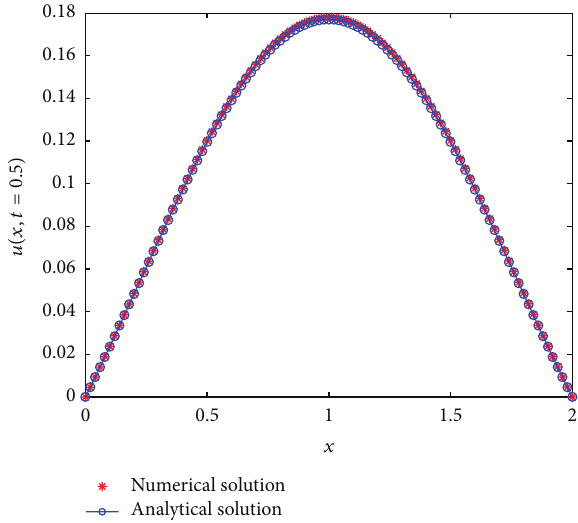
Figure 1: The comparison of the numerical solution with the analytical solution at 𝑡 = 0.5 . (𝜏 = 1/400, ℎ = 1/20) .